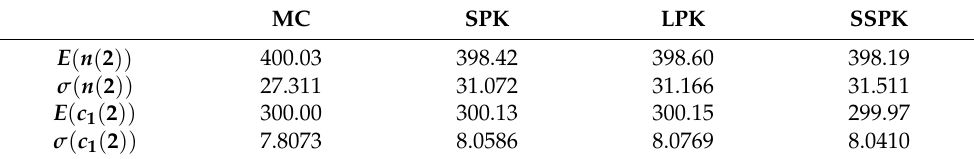
Table 1. Population for the first case study at t = 2 s.